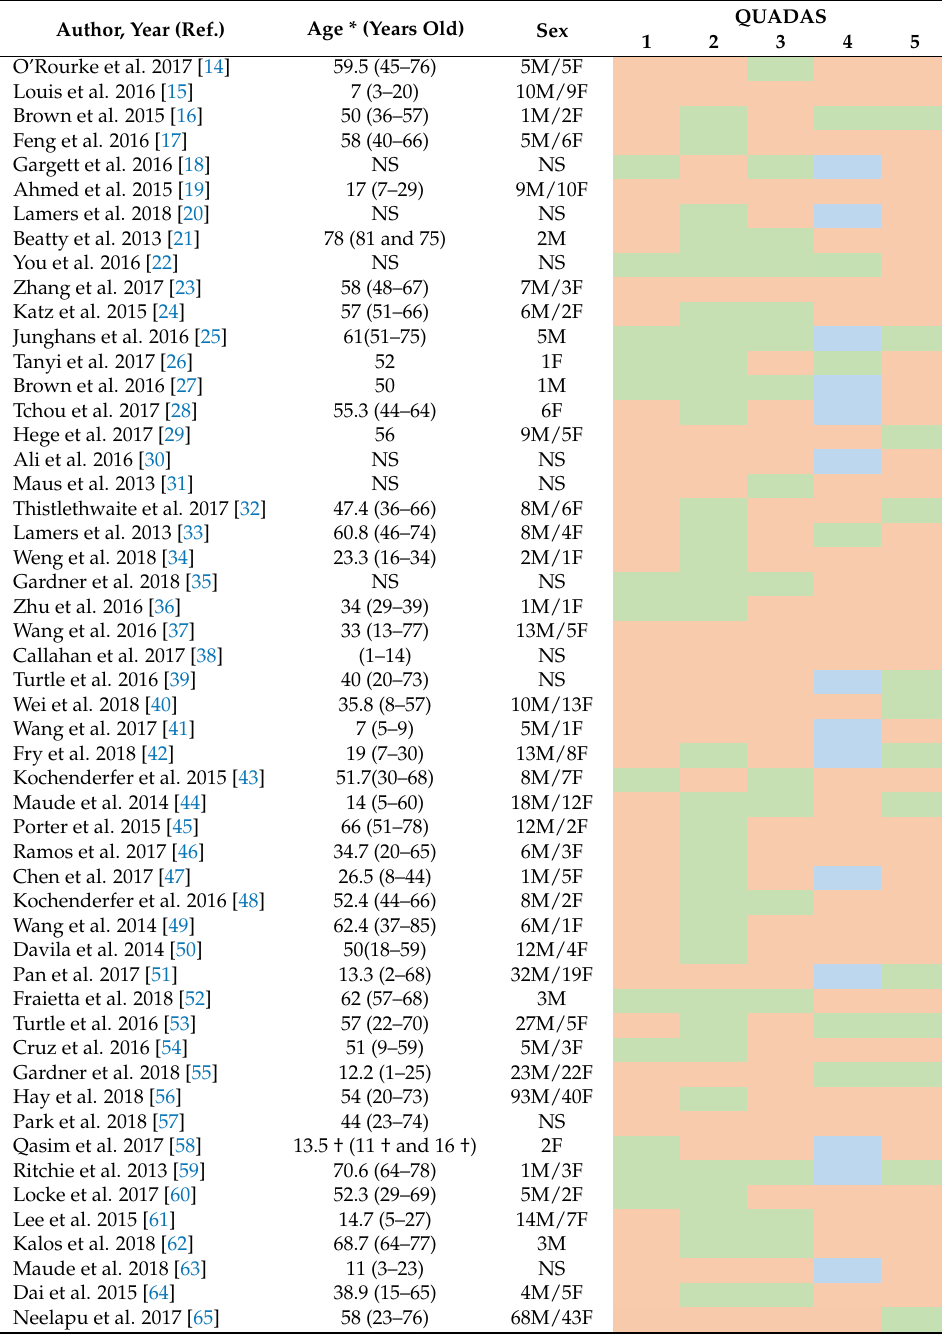
Table 1. Basic patient characteristics of the studies included in the meta-analysis and the results of methodological quality assessment using the QUADAS-2